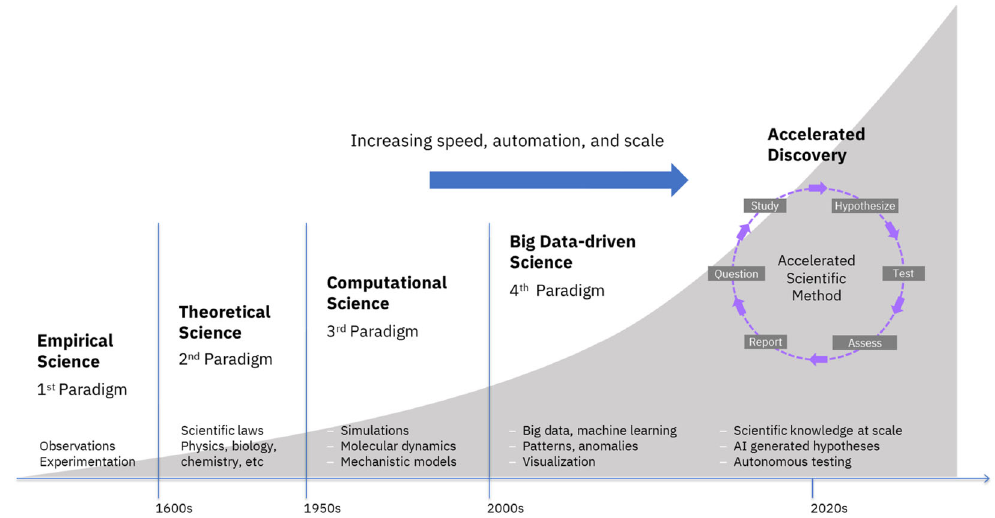
Fig. 1 The progression of the scienti fi c method. Science has seen a number of major paradigm shifts, which have been driven by the advent and advancement of core underlying technology.